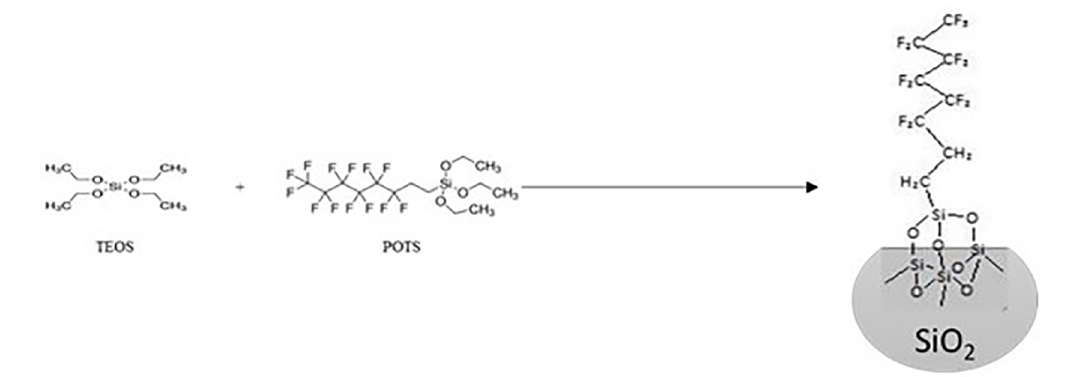
Figure 2. Representative scheme of polycondensation